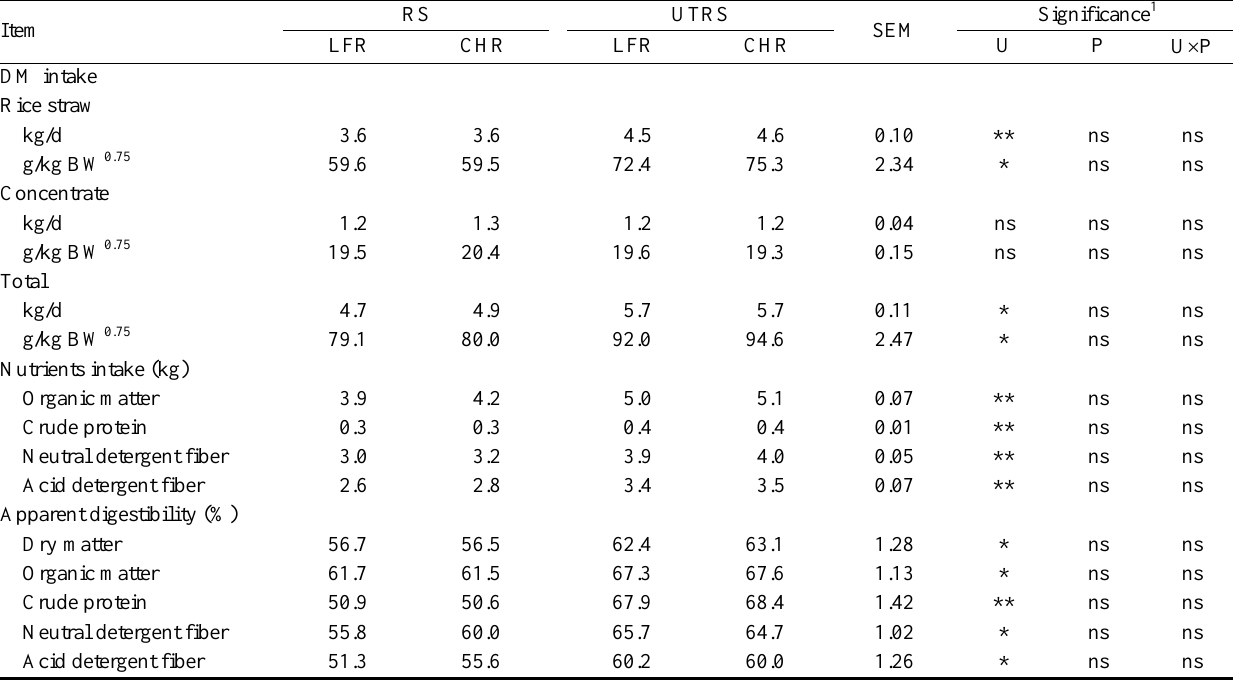
Table 2. Effect of physical form and urea treatment of rice straw on feed intake, nutrient intake and apparent nutrient digestibility of dairy